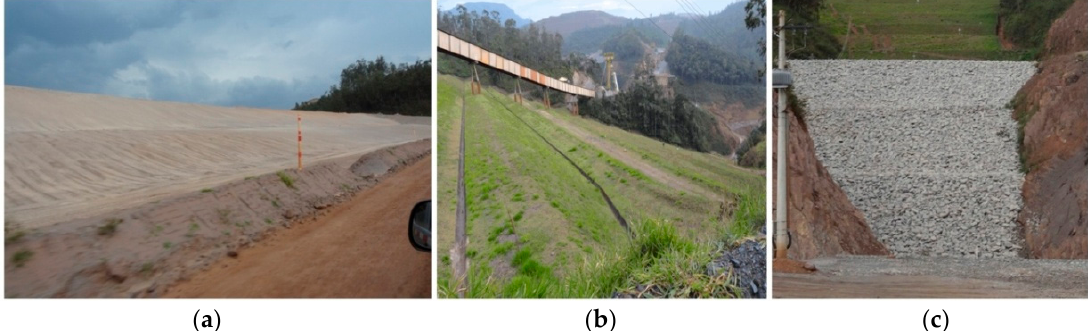
Figure 9. Field pictures presenting the upper sector ( a ), steepest sector ( b ) and buttress sector ( c ) of the main Germano dam.